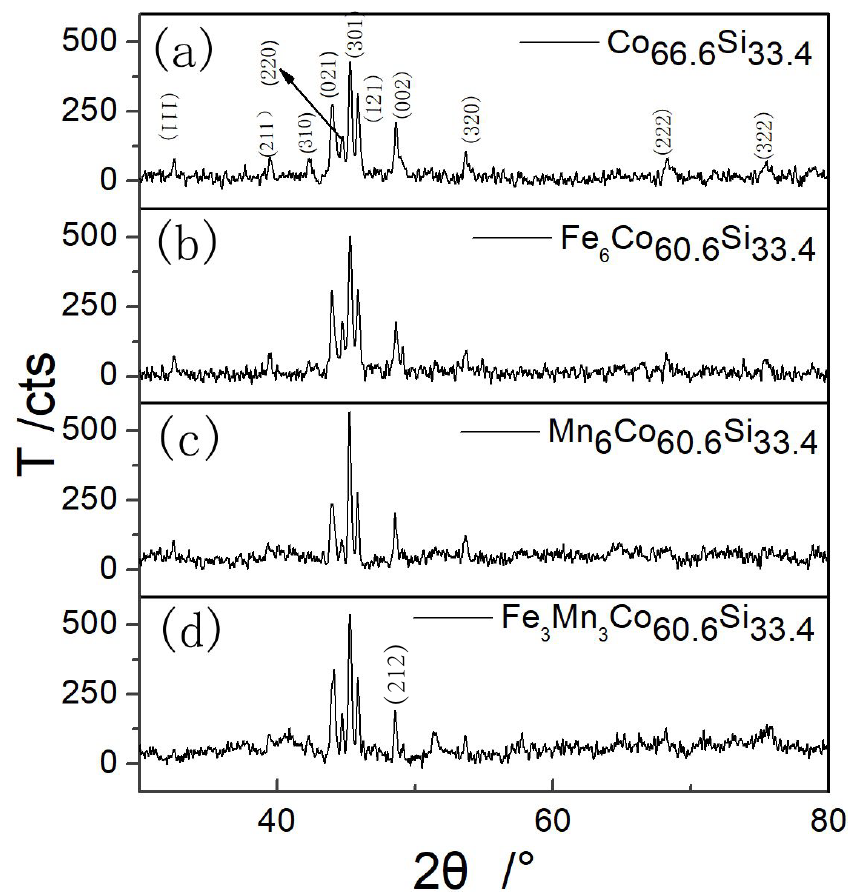
Figure 1. XRD patterns of ( a ) as-prepared Co 66.6 Si 33.4 , ( b ) Fe doped Co 66.6 Si 33.4 , ( c ) Mn doped Co 66.6 Si 33.4 and ( d ) Fe and Mn co-doped Co 66.6 Si 33.4